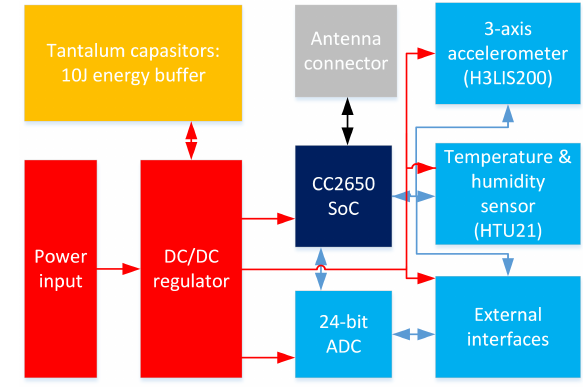
Figure 4. Structure of the sensor node.